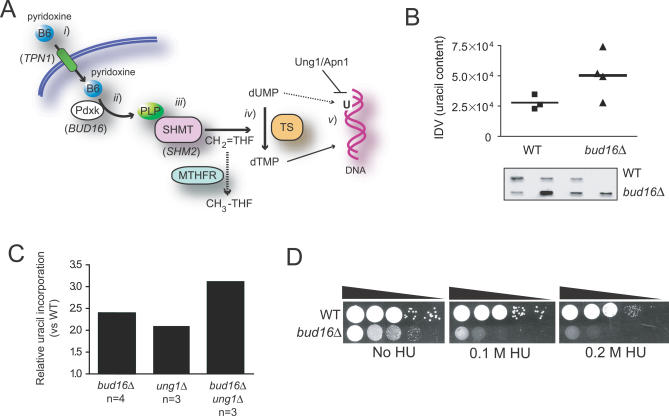
PLP levels Are Required for Optimal dTMP Biosynthesis(A) The intersection of vitamin B6 and dTMP biosynthesis. (i) Dietary vitamin B6 (i.e., pyridoxine) is imported into the cell via the Tpn1 transporter (S. cerevisiae gene names in brackets). (ii) Pdxk phosphorylates the B6 vitamers (pyridoxine, pyridoxamine, and pyridoxal) to generate PLP, which acts (iii) as a cofactor for serine hydroxymethyl transferase (SHMT). (iv) SHMT is necessary for the formation of methylenetetrahydrofolate (CH2=THF), the methyl group donor for the conversion of dUMP into dTMP. (v) A deficiency in PLP is predicted to reduce dTMP levels leading to a nucleotide pool imbalance and incorporation of uracil into DNA.(B) bud16Δ cells accumulate uracil in DNA, as measured by a modified aldehydic slot blot assay. The results of the slot blot (bottom panel) were quantified and shown in the graph. IDV refers to the integrated density values of the bands.(C) Uracil accumulation in the bud16Δ genomic DNA is comparable to that observed in ung1Δ DNA.(D) bud16Δ cells are sensitive to nucleotide depletion by hydroxyurea at 0.2 M. The results of a colony forming assay can also be found in Table S3.